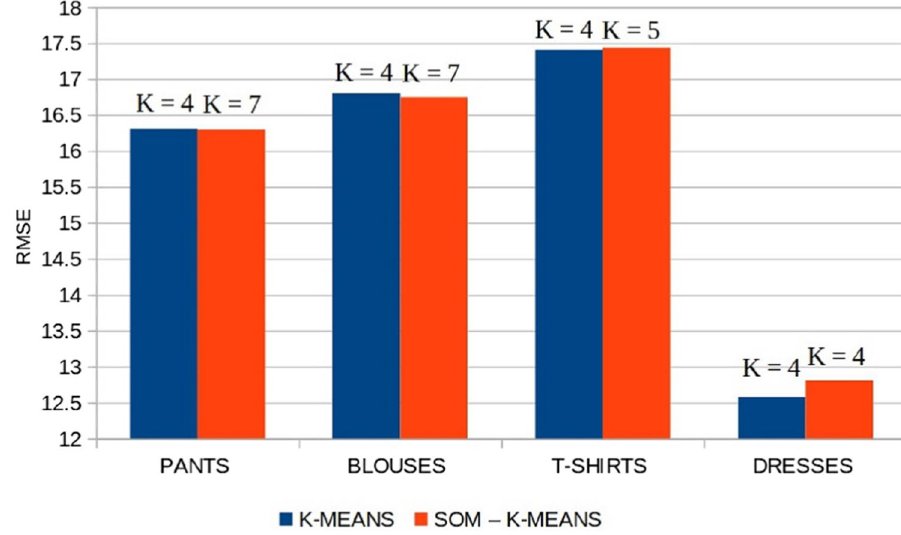
Fig. 9 Root mean square errors when using K-means and SOM- K-means as clustering